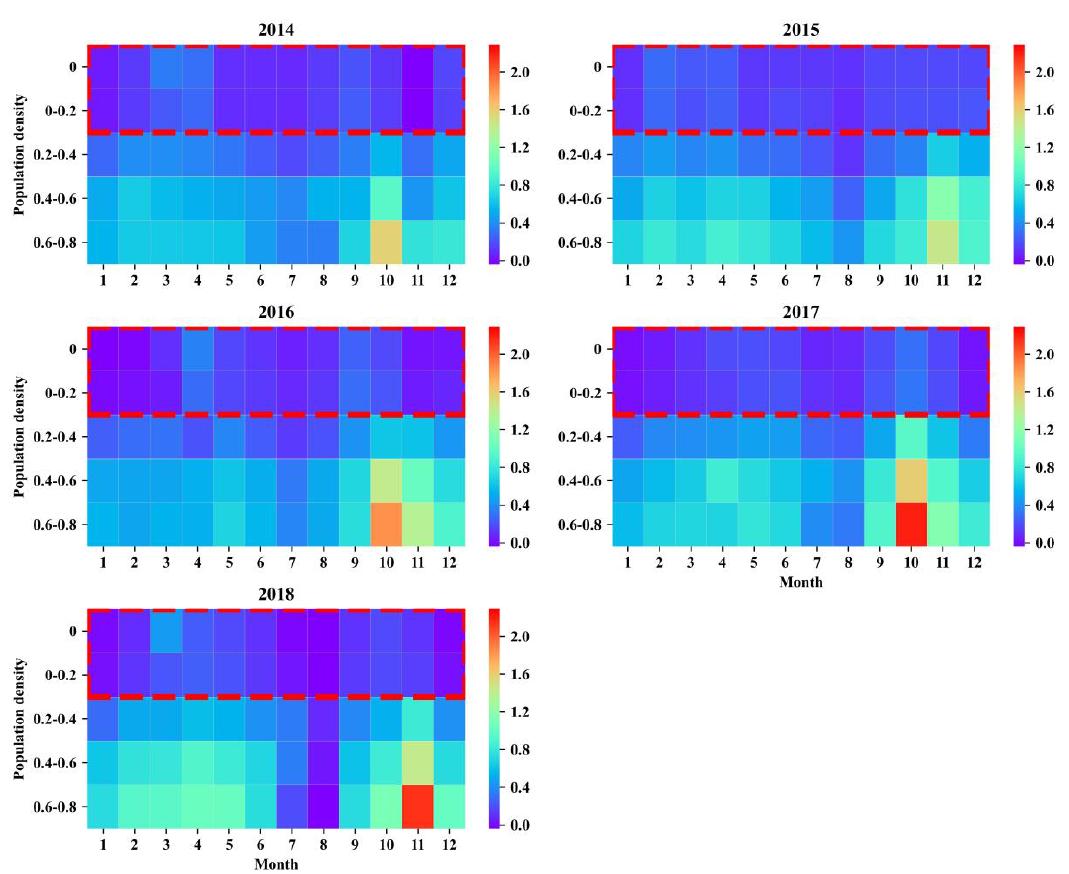
Figure 4. The mean value in different population density. The vertical axis represents population density and population density level is 0, 0–0.2, 0.2–0.4, 0.4–0.6, and 0.6–0.8, respectively.